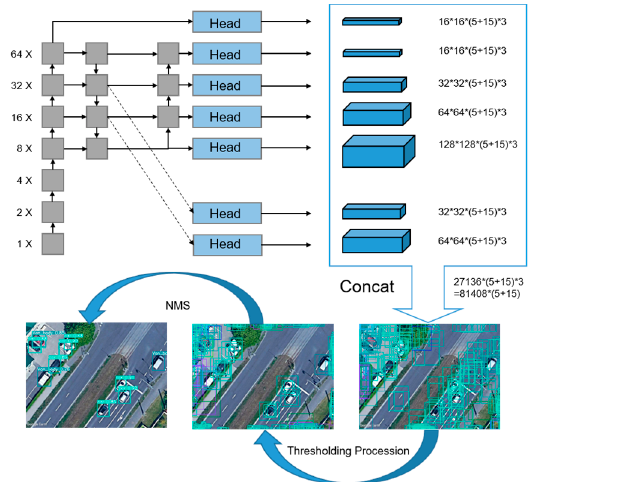
Figure 2. The overall structure of YOLO-HR.